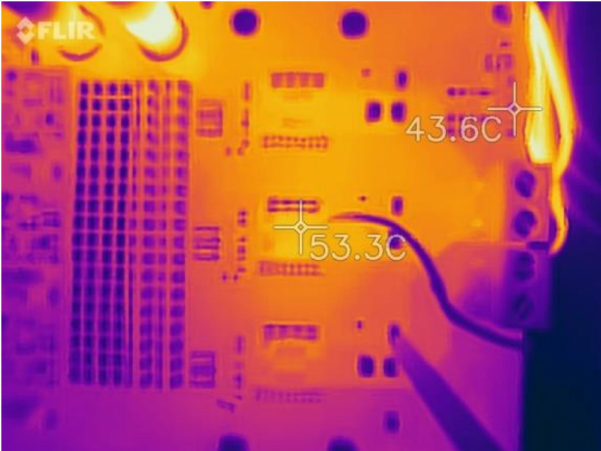
Figure 29. Infrared picture of experimental board without heat sink at V dc = 48 V, I a,b,c,rms = 10 A, f sw = 50